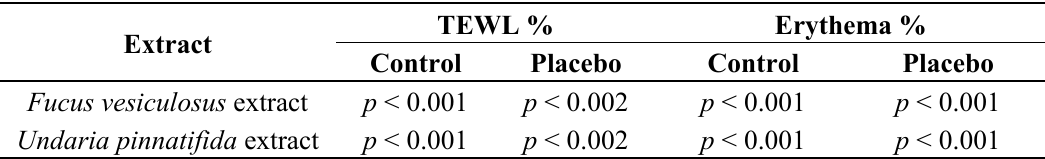
Table 10. Significant differences between data sets for Study Scheme 1 (Student’s t -test for paired